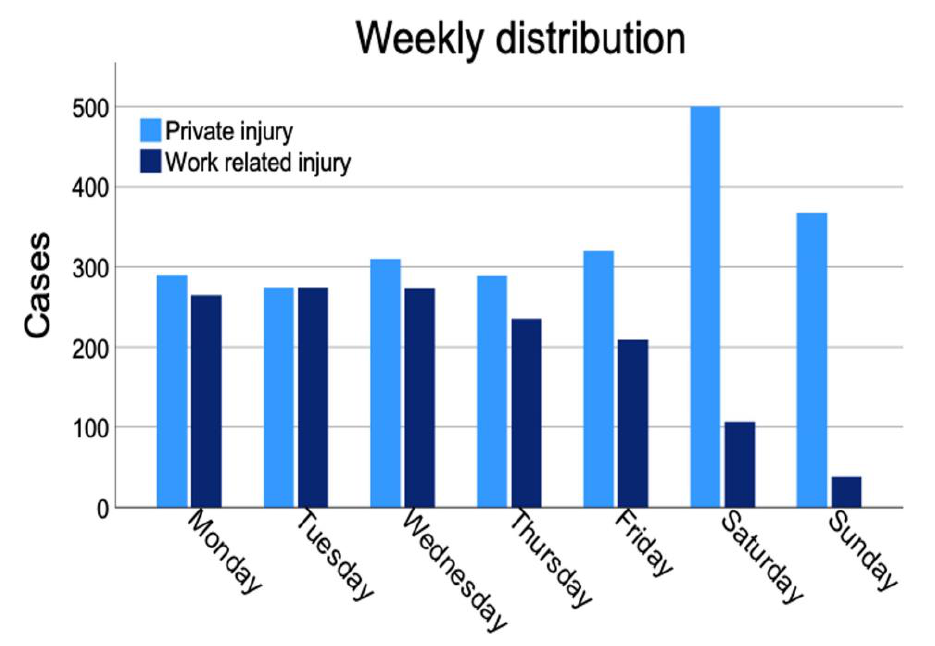
Figure 5. Timepoint of injury for work related and private injuries.